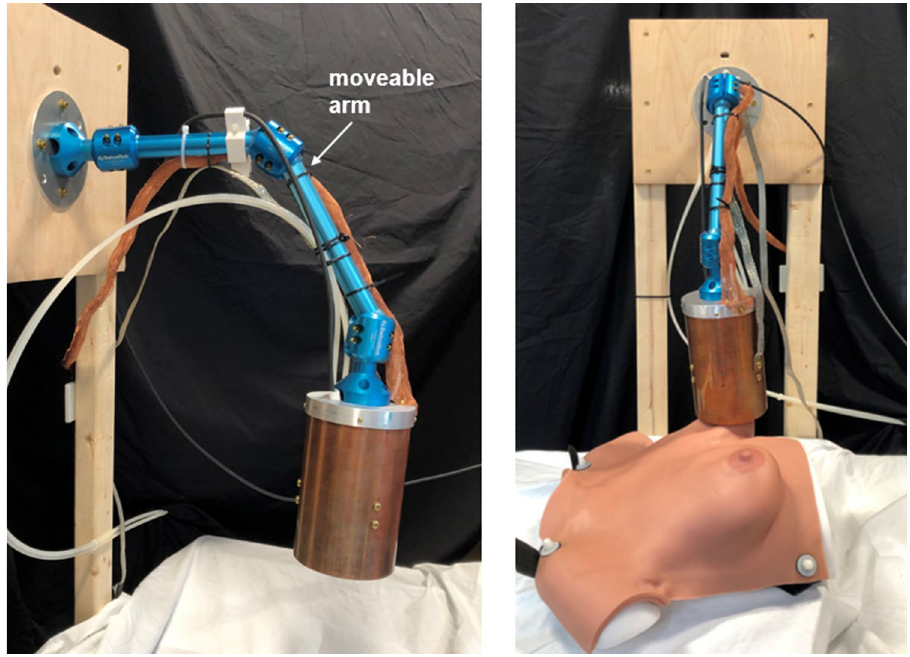
Figure 4. MP detector mounted on moveable arm. Photos at two angles, one with the breast phantom and one without, are shown. The copper tube and aluminum cap are attached to an articulating arm made of anodized aluminum with three joints, enabling a wide range of motion so that the detector can be moved by hand to and from any desired positions. Water tubes and wires are visible and secured to the arm.